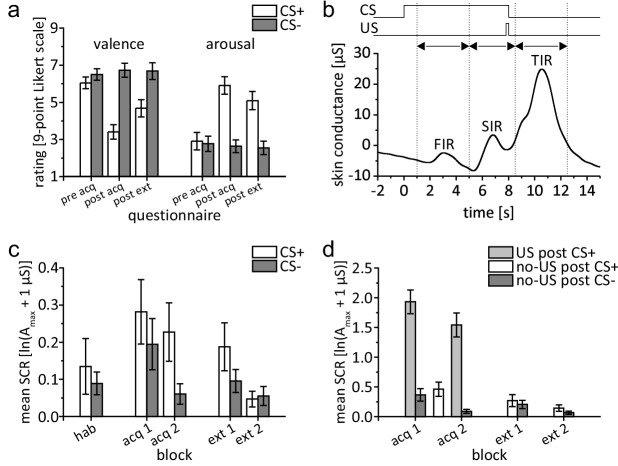
Behavioral data.(a) Group mean valence and arousal ratings for CS+ and CS- during acquisition and extinction. (b) Example of bandpass filtered individual SCR in a paired CS+/US trial depicting response interval windows and displaying a distinct response in each interval. (c) Group mean SIR. (d) Group mean TIR. Please note the different scales of the y-axis used for illustration purposes. Error bars represent standard errors of the mean. acq 1, acq 2 = early and late acquisition; CS = conditioned stimulus; ext 1, ext 2 = early and late extinction; FIR = first interval response; hab = habituation; SCR = skin conductance response; SIR = second interval response; TIR = third interval response; US = unconditioned stimulus.10.7554/eLife.46831.005Figure 2—source data 1.Mean SCR data.